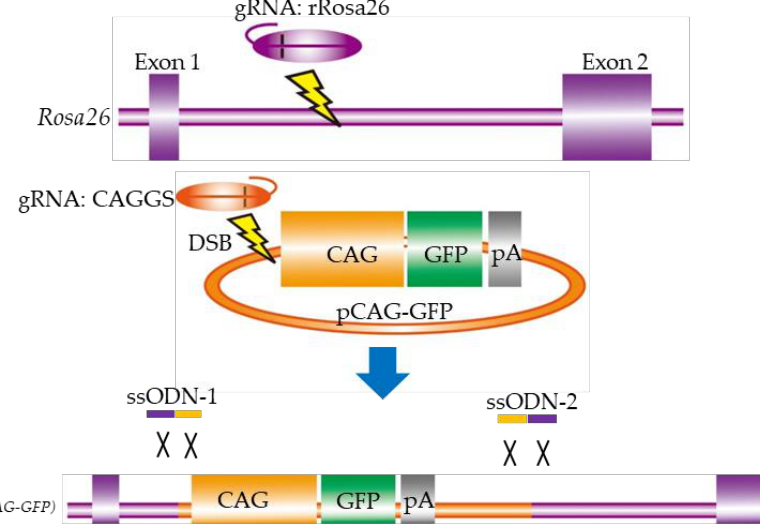
Figure 3. Schematic representation of the two-hit by gRNA and two-oligo with plasmid (2H2OP) method for the production of CAG-GFP knock-in (KI) rats generated using the CRISPR/Cas9 system. In the first step, Cas9, together with two gRNAs targeting the rat Rosa26 locus and the CAG promoter in the GFP plasmids, cuts the target sites. In the second step, two ssODNs ligate each cut end to join the genomic DNA and the plasmid DNA via HDR. This figure was drawn in-house, based on the data shown in the paper of Yoshimi et al. [64]. Abbreviations: CAG, chicken β -actin-based promoter; GFP, green fluorescent protein; KI, knock-in; ssODNs, single-stranded oligodeoxynucleotides; pA, poly(A) sites.